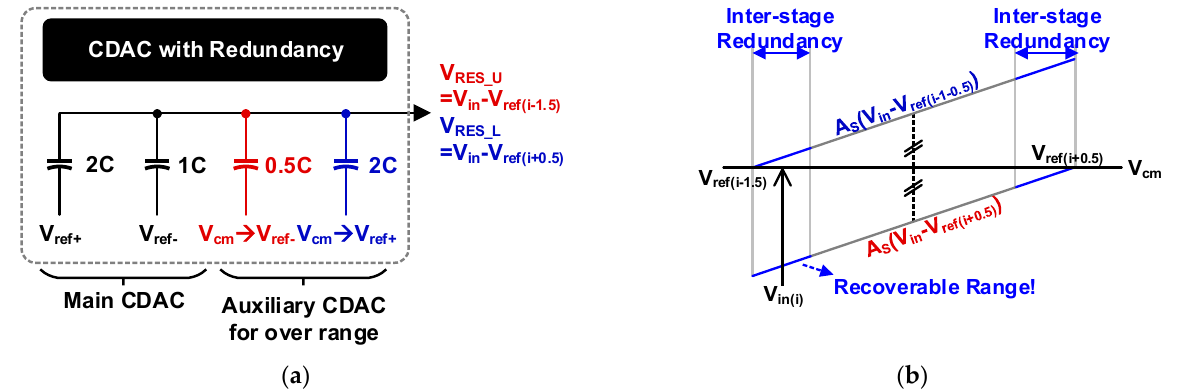
Figure 8. Proposed over-ranged residue generation technique: ( a ) Schematic for conceptual operation; ( b ) Residue profile with inter-stage redundancy.